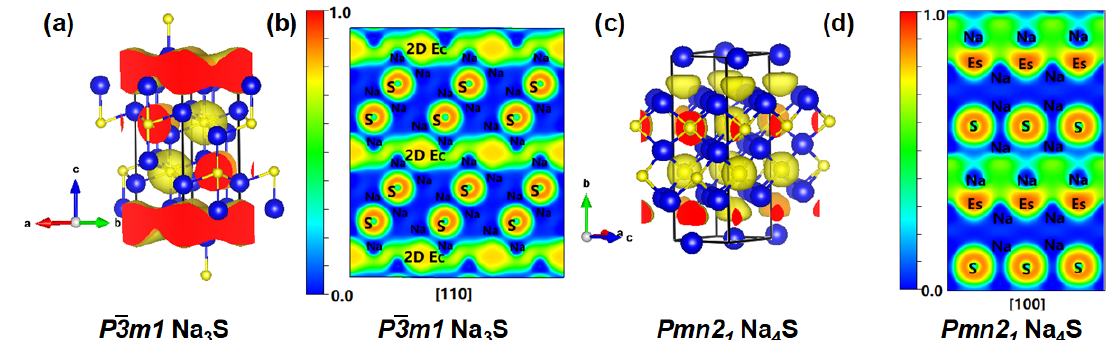
Figure 6. The electron localization function (ELF) plots of sodium rich phases at 0 GPa. P ¯ 3 m 1-Na 3 S: ( a ) ELF isosurface plot using an isovalue of 0.5, and ( b ) slice of the ELF in the [100] plane. Pmn 2 1 -Na 4 S: ( c ) ELF isosurface plot with an isovalue of 0.8, and ( d ) slice of the ELF in the [110] plane. In the two-dimensional plots, the positions of the S and Na atoms are denoted, as is the plane of the two-dimensional electron cloud (Ec) and the positions of the interstitial electron pairs